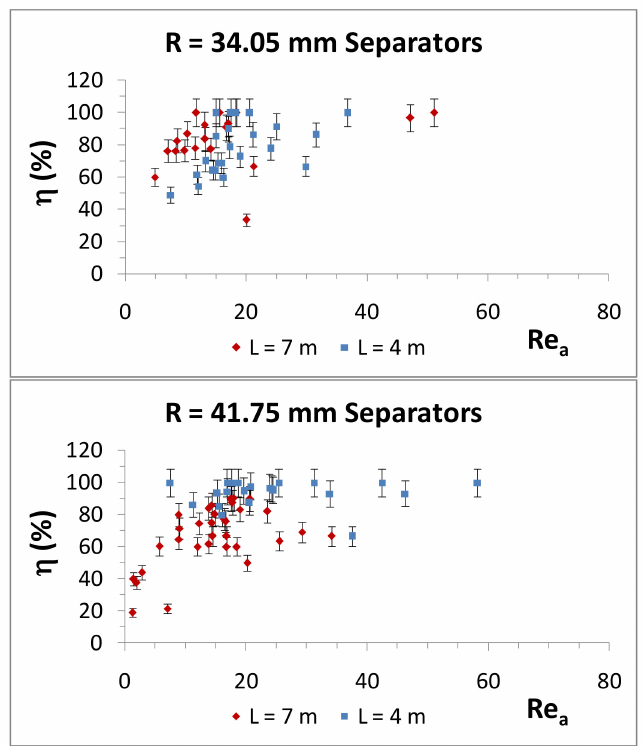
Figure 11. Relationship between the apparent Reynolds number Re a and the relative separation yield η (%) for the separators tested with different helix radiuses R (34.05 mm and 41.75 mm) and tube lengths L (4 and 7